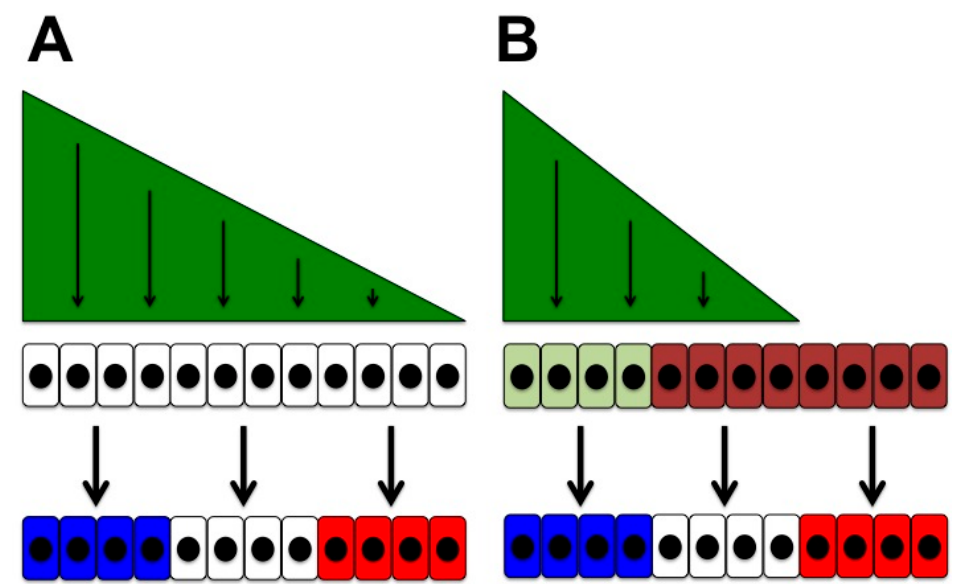
Figure 1. Two scenarios for the induction of multiple cellular responses (blue, white, red) by a signalling factor (green). ( A ) The factor acts as a morphogen that induces multiple responses dose-dependently; ( B ) A pre-pattern in the receiving cells (light green vs. brown) results in differential responses to the signal—the receiving cells display differential competence .